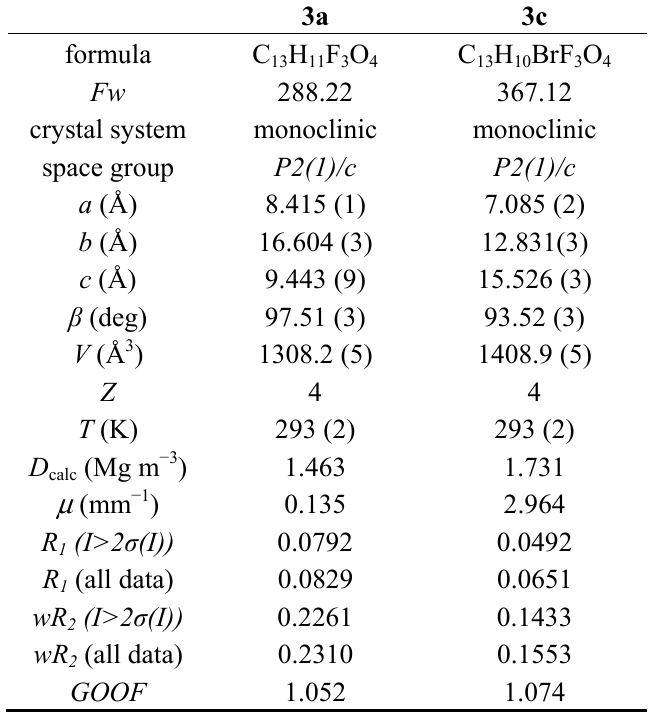
Table 3. Crystal data and structure refinement for 3a and 3c .